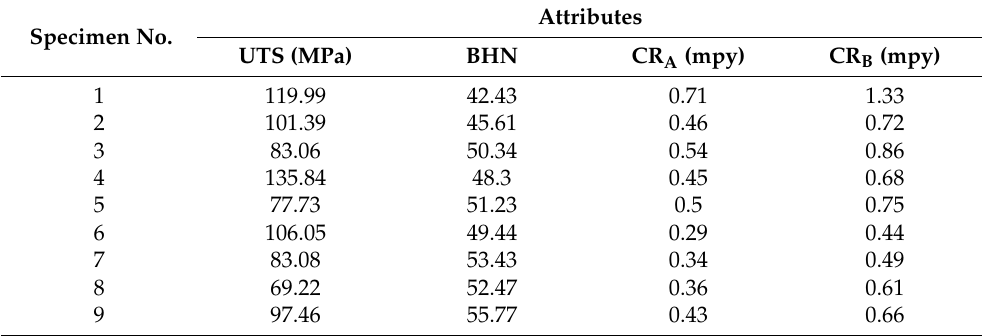
Table 8. Decision